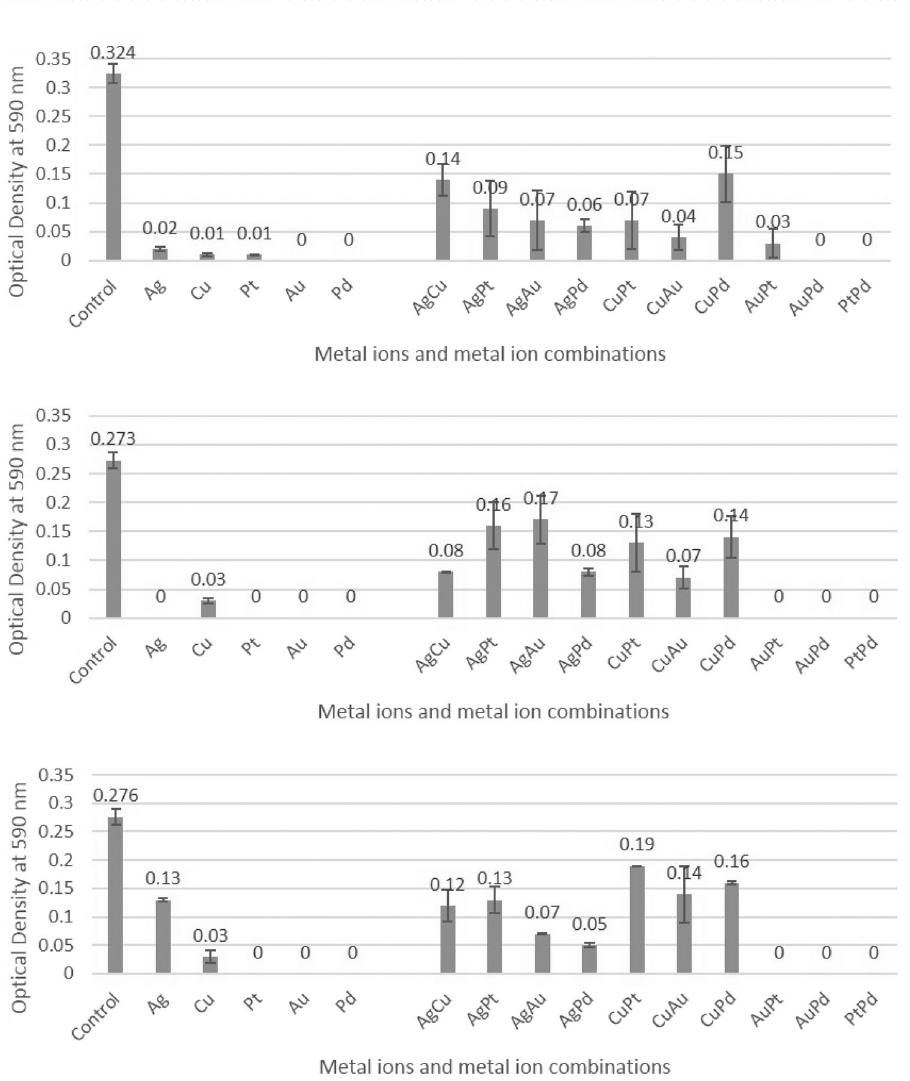
Figure 3. ( a – c ) Biofilm growth in the presence of metal ions tested individually and in combination at 500 mgL-1 against ( a ) K. pneumoniae , ( b ) A. baumannii and ( c ) E. faecium using crystal violet biofilm assay. The metals were tested in a 1:1 ratio. Au = gold, Cu = copper, Pt = platinum, Pd = palladium and Ag = silver (n =